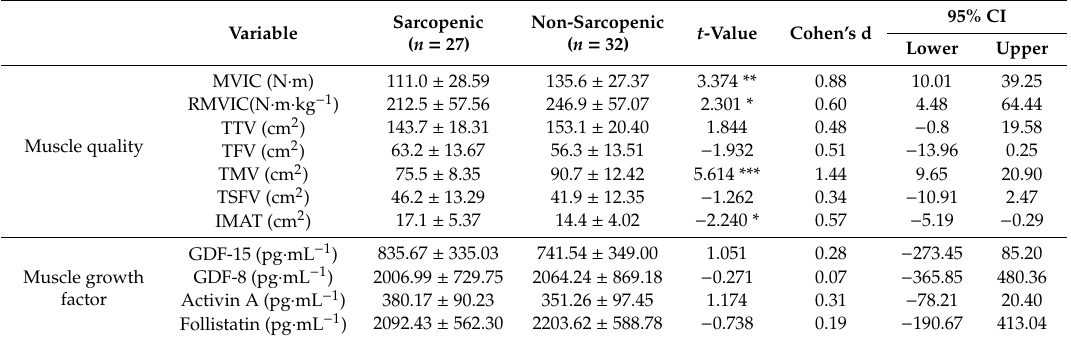
95% CI Lower Upper − 0.29